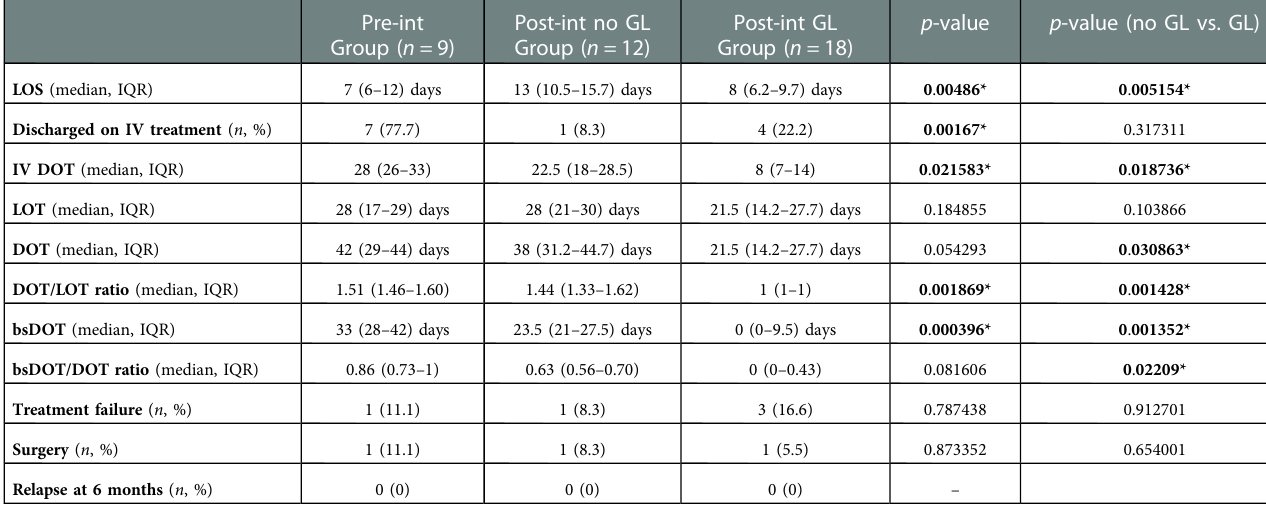
TABLE 8 Outcomes - SA.